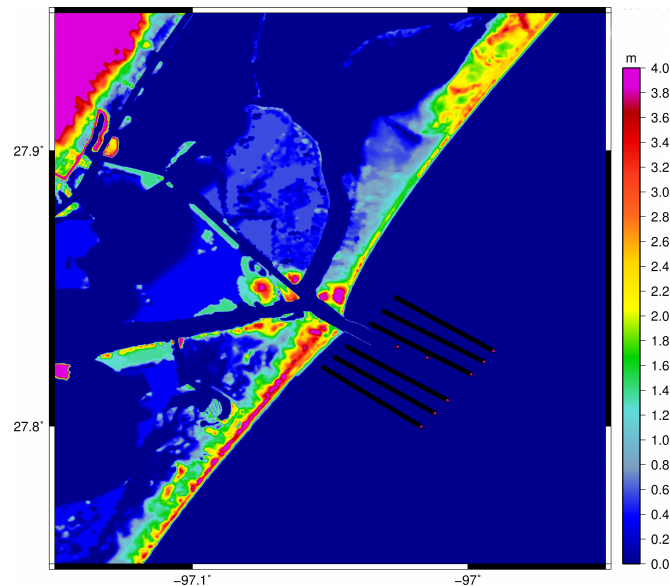
Figure 8. Initial condition I-1964 particles outside the Aransas Pass